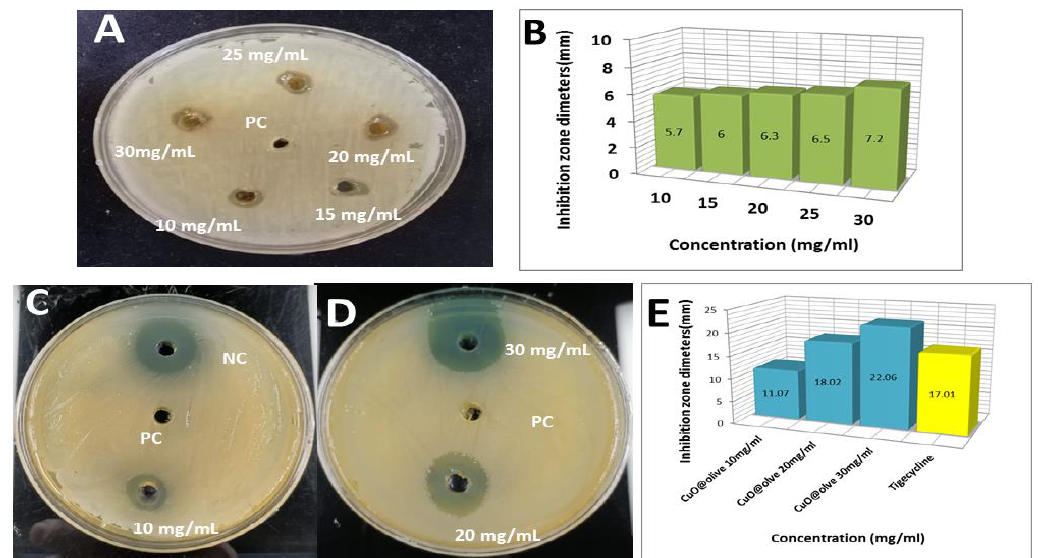
Figure 7. ( A ) Zone of inhibition (mm) plate with diverse concentrations 10, 15, 20, 25, and 30 mg/mL of OVLe; ( B ) Enterococcus faecium bacterial growth curve; ( C , D ) zone of inhibition (mm) plate with diverse concentrations 10, 20, and 30 mg/mL of CuO @OVLe NCs ; ( E ) Enterococcus faecium bacterial growth curve.